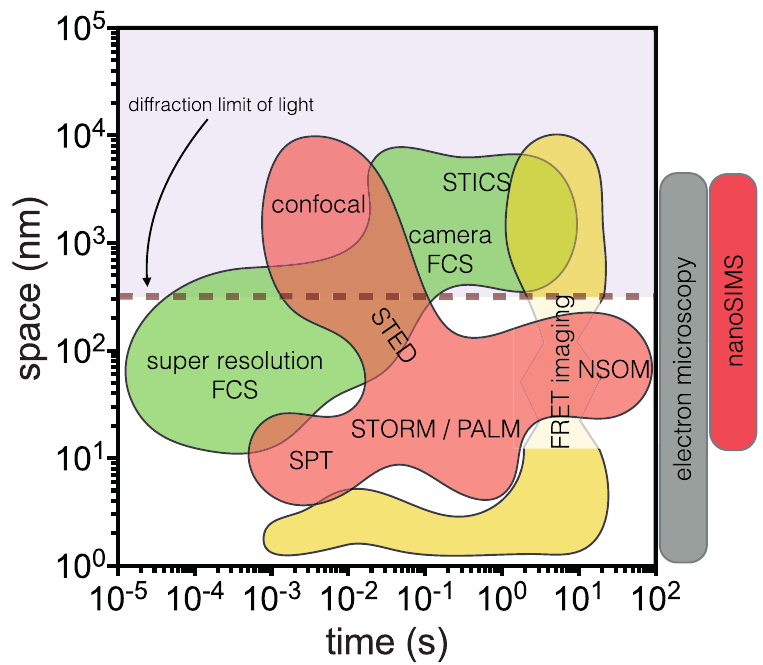
Figure 5. Space and time resolution of current methods. Representation of the landscape that current methods occupy in the space and time axes. Abbreviations: FCS, fluorescence correlation spectroscopy; FRET, Förster resonance energy transfer; NSOM, near-field scanning optical microscopy; PALM, photoactivatable localization microscopy; SPT, single particle tracking; STED, stimulated emission depletion; STICS, spatio-temporal image correlation spectroscopy; STORM, stochastic optical reconstruction